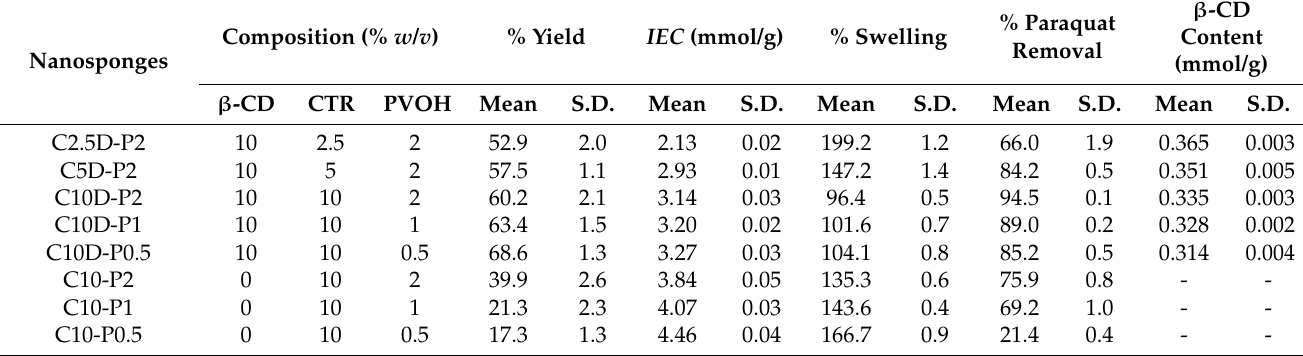
Table 1. Physicochemical properties of poly(vinyl alcohol)-cyclodextrin nanosponges and their derivatives.